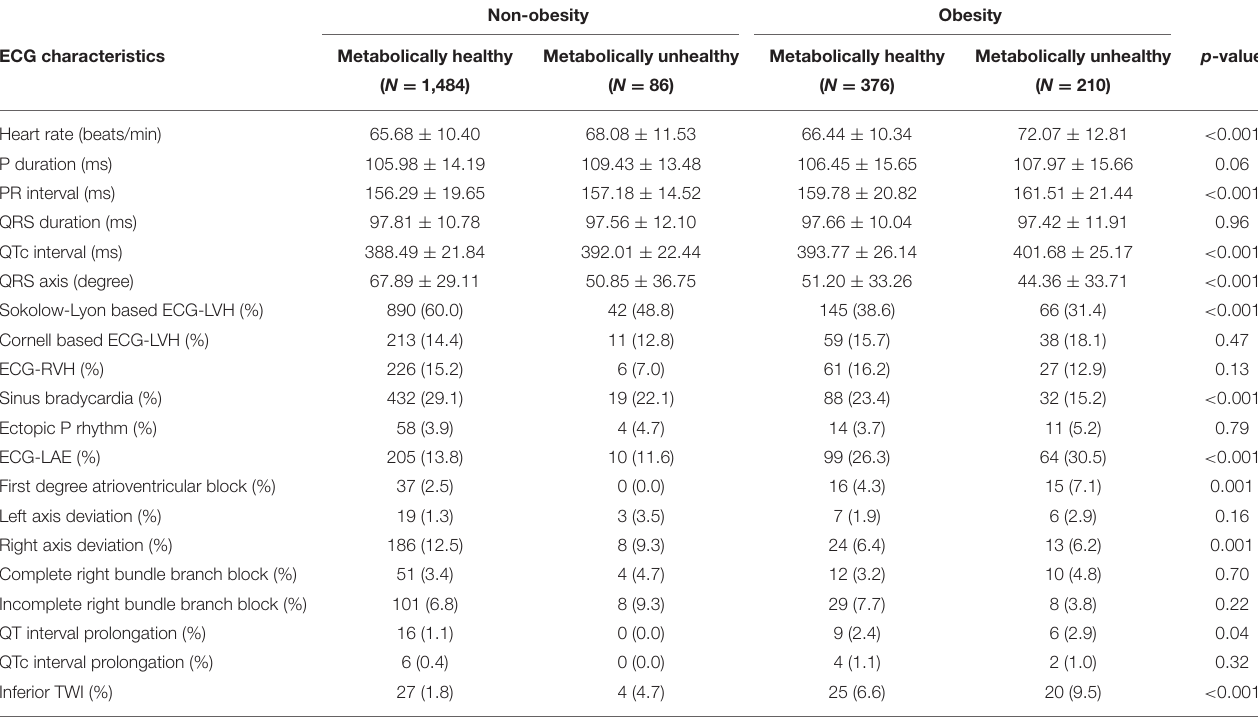
TABLE 2 | Electrocardiographic characteristics of four obesity phenotypes classified by body mass index and metabolic